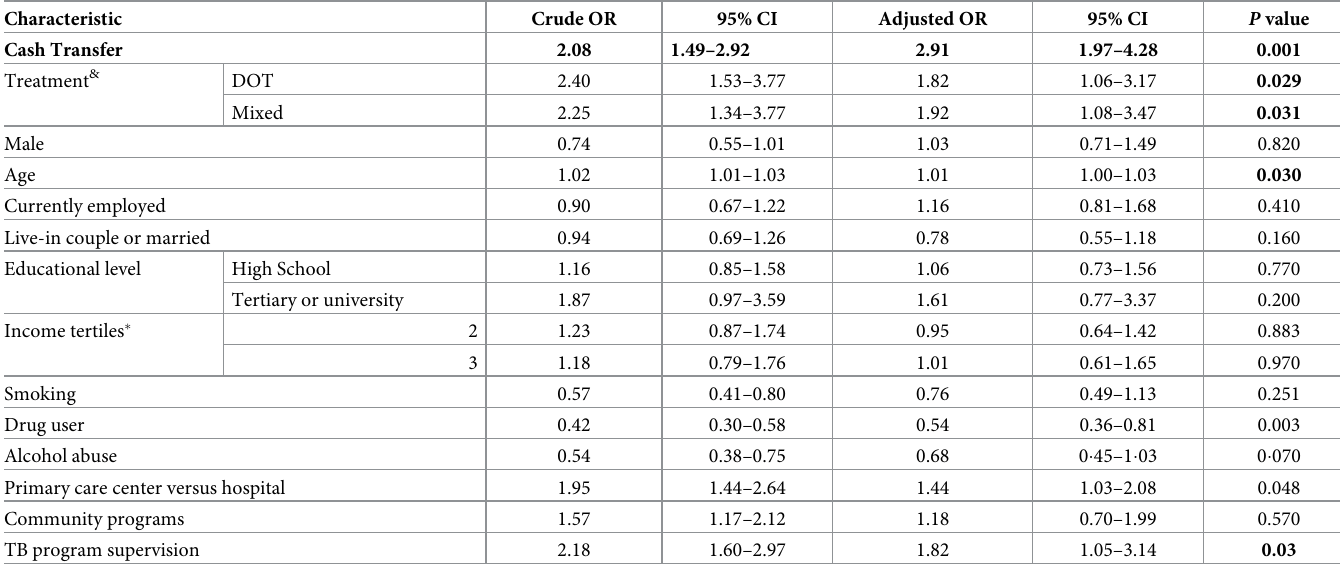
Table 3. Multilevel model: Factors associated to treatment